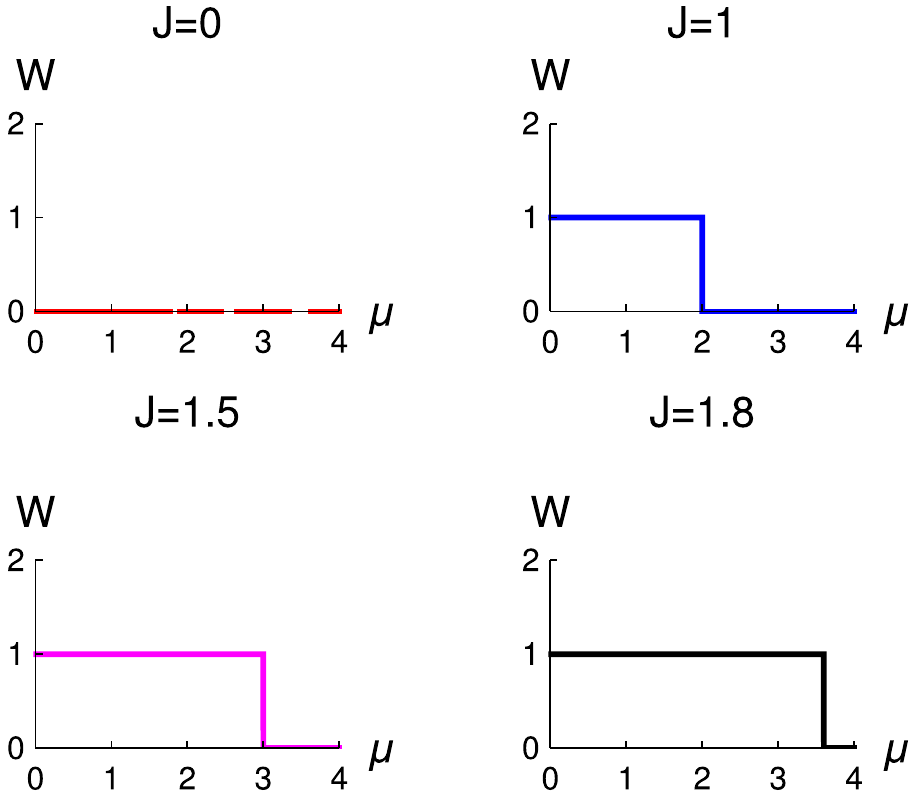
Figure 2. The variation of winding number ( W ) with μ for different values of J . Different figures are for the different values of J , red ( J = 0.5), blue ( J = 1), magenta ( J = 1.5) and black ( J = 1.8), Δ =